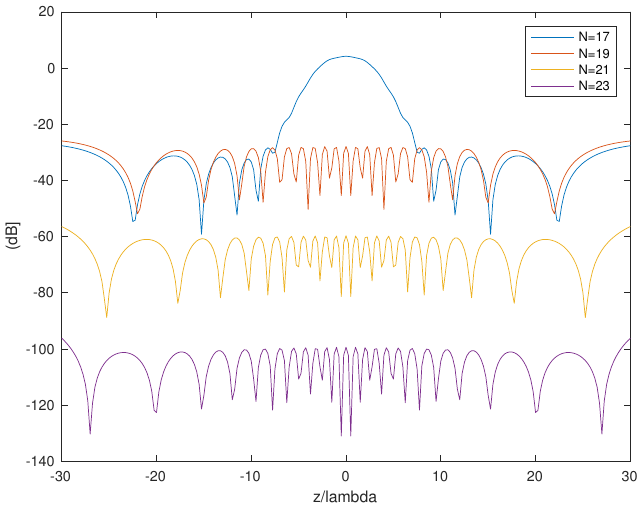
Figure 4. Error [dB] of the interpolated field versus the number of basis functions